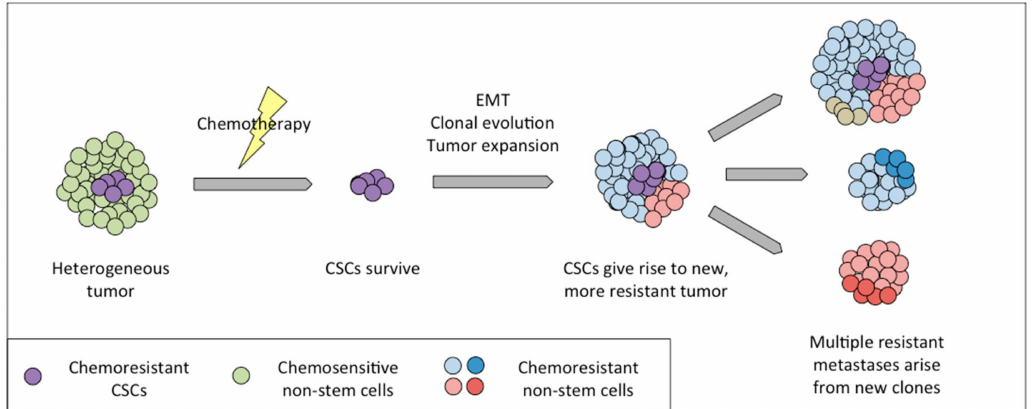
Figure 2. Contribution of cancer stem cells (CSCs) to recurrence and metastasis. A tumor with populations of CSCs (purple) and non-stem bulk tumor cells (green) treated with chemotherapy may eliminate all fast dividing cells, leaving resistant CSCs behind. CSCs will expand and di ff erentiate, undergoing epithelial to mesenchymal transition to give rise to recurrence. Recurrent tumors (red, blue) tend to be resistant to first line chemotherapy, metastasize widely, and continue to evolve (dark red, dark blue), ultimately leading to lethality to the